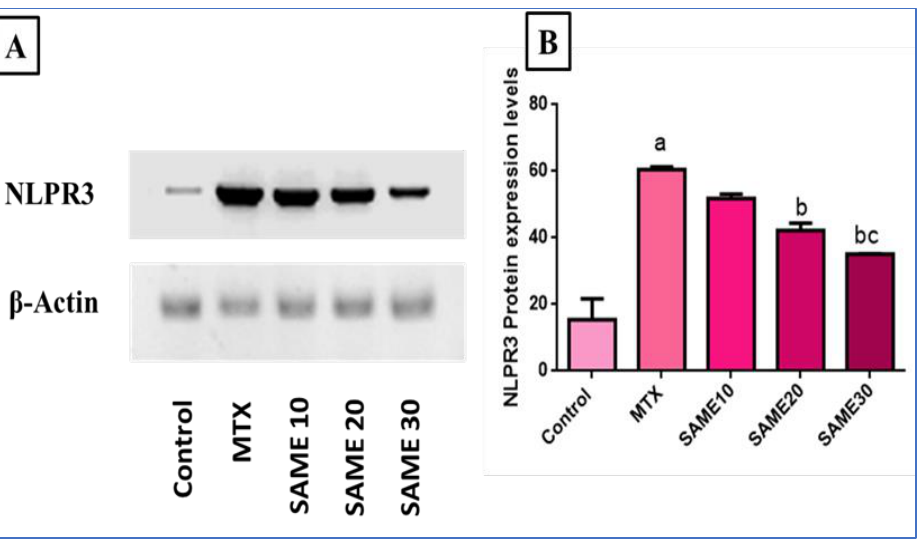
Figure 6. Effect of the SAME pre-treatment on the expression of NLPR3 in the liver tissues. ( A ) Representative western blot bands of NLPR3/ β -actin ( B ) Graphical presentation of NLPR3 expression level in hepatic tissue. Hepatotoxicity was induced by a single I.P injection of MTX (20 mg/kg). SAME 10, 20 and 30 were given orally once daily for 5 consecutive days and a single injection of MTX on the sixth day. Data expressed as mean ± SD ( n = 8/group) as the experiments were performed in three independent triplicates. Significant difference vs. a respective control, b respective MTX group, c respective SAME 10 group, each at p < 0.05.